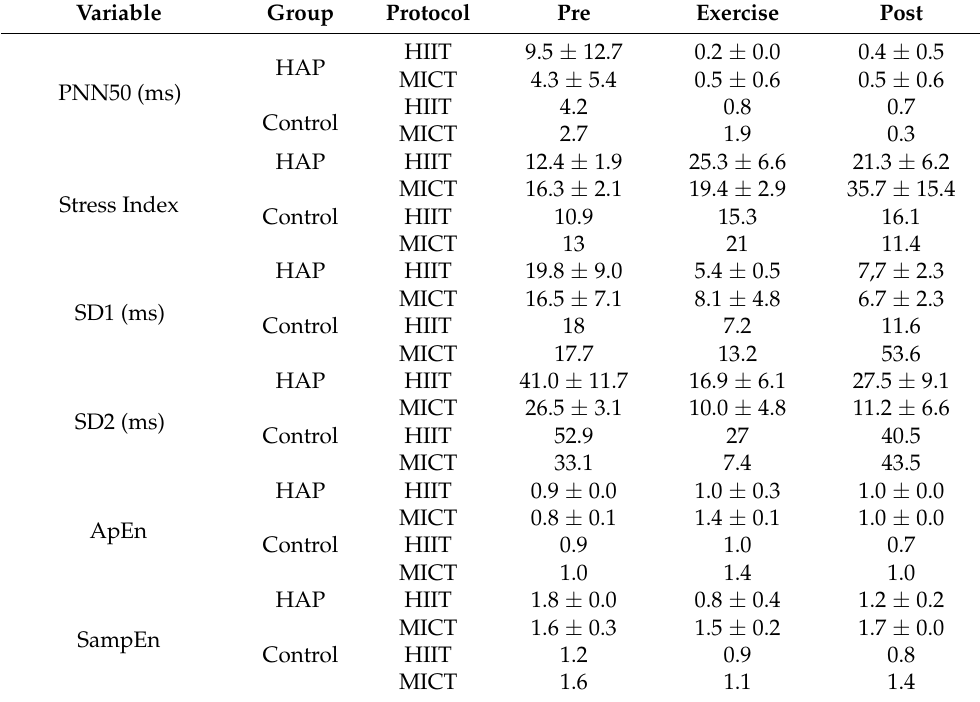
Table 3. Cont. Variable Group Protocol